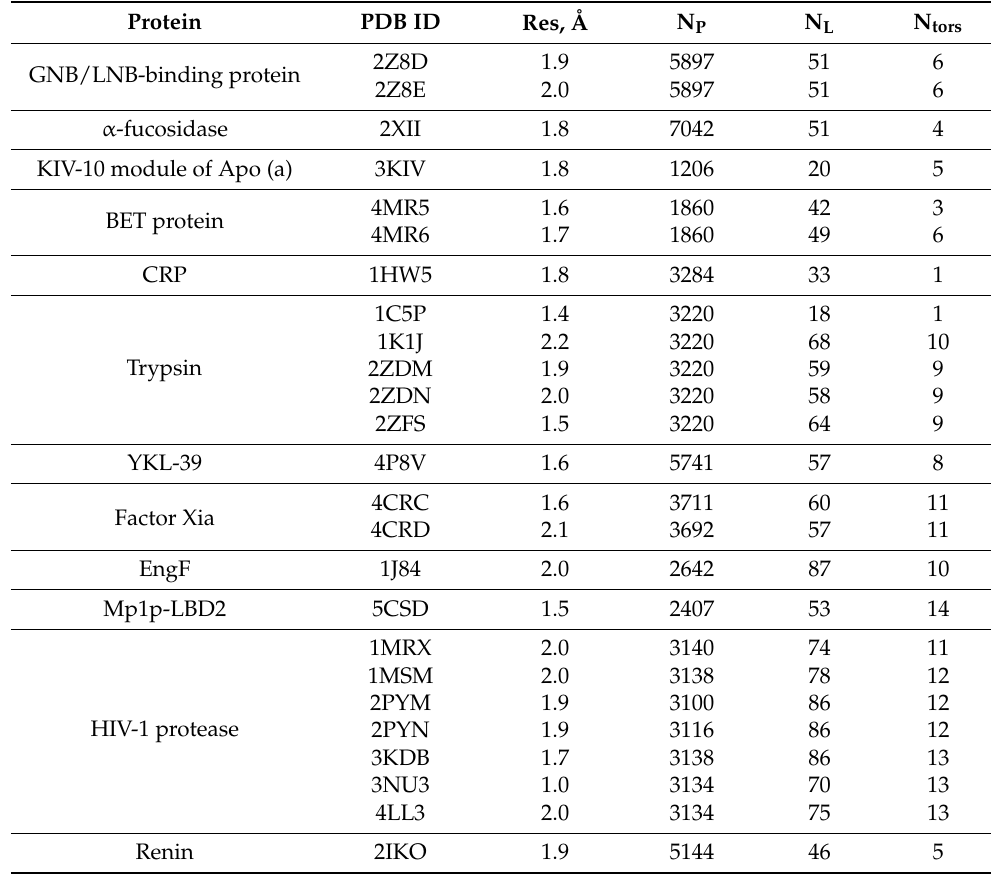
Table 1. Protein-ligand complexes selected for the test set and their characteristics: PDB ID is the identifier of the complex in Protein Data Bank, protein names, Res is the resolution of the complex, N P , N L are numbers of protein and ligand atoms, respectively, N tors is the number of ligand torsions, i.e., the internal rotations around ordinary chemical